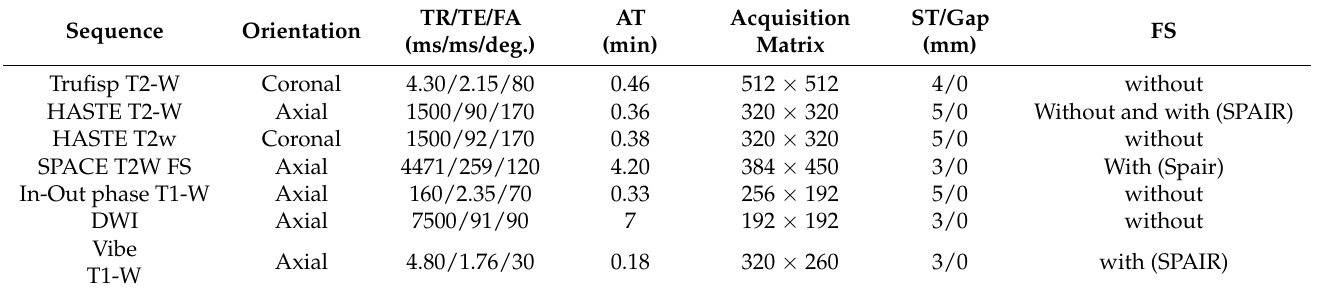
Table 2. MR acquisition